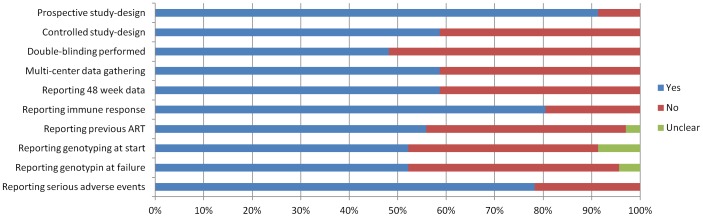
Quality assessment of the selected studies in systematic review.Summary of the proportion of studies that fulfilled each quality assessment criterion. When no clear answer could be obtained for a specific criterion, it was classified as “unclear”. ART = Antiretroviral Treatment.